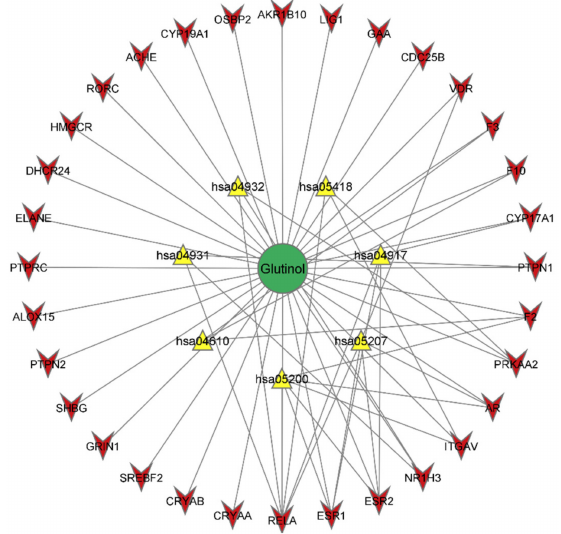
Figure 5. Glutinol-target-pathway